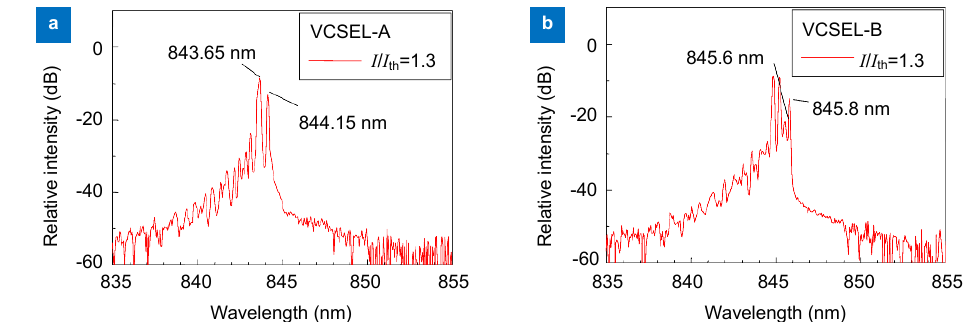
Fig. 5 | Optical spectra of the VSCELs with ( a ) 6- μ m and ( b ) 10- μ m oxide confined apertures.